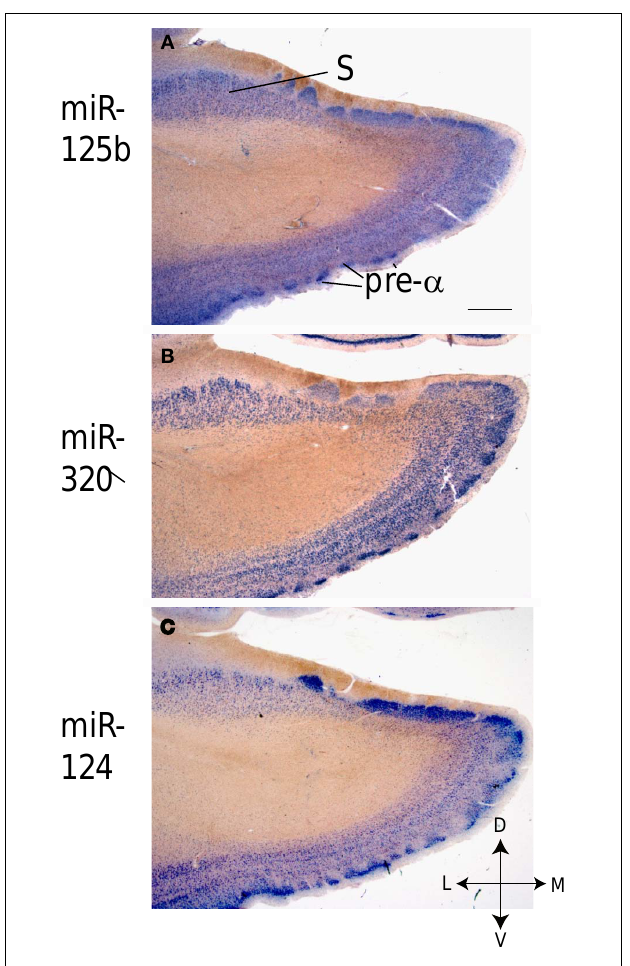
FIGURE 5 | In situ hybridization of entorhinal cortex (layer pre- α is noted) and pre-, para- and pro-subiculum (S) using probes against miRNAs (A) miR-125b (B) miR-320, and (C) miR-124. All stains were performed on Case 1. Scale bar = 1500 microns.